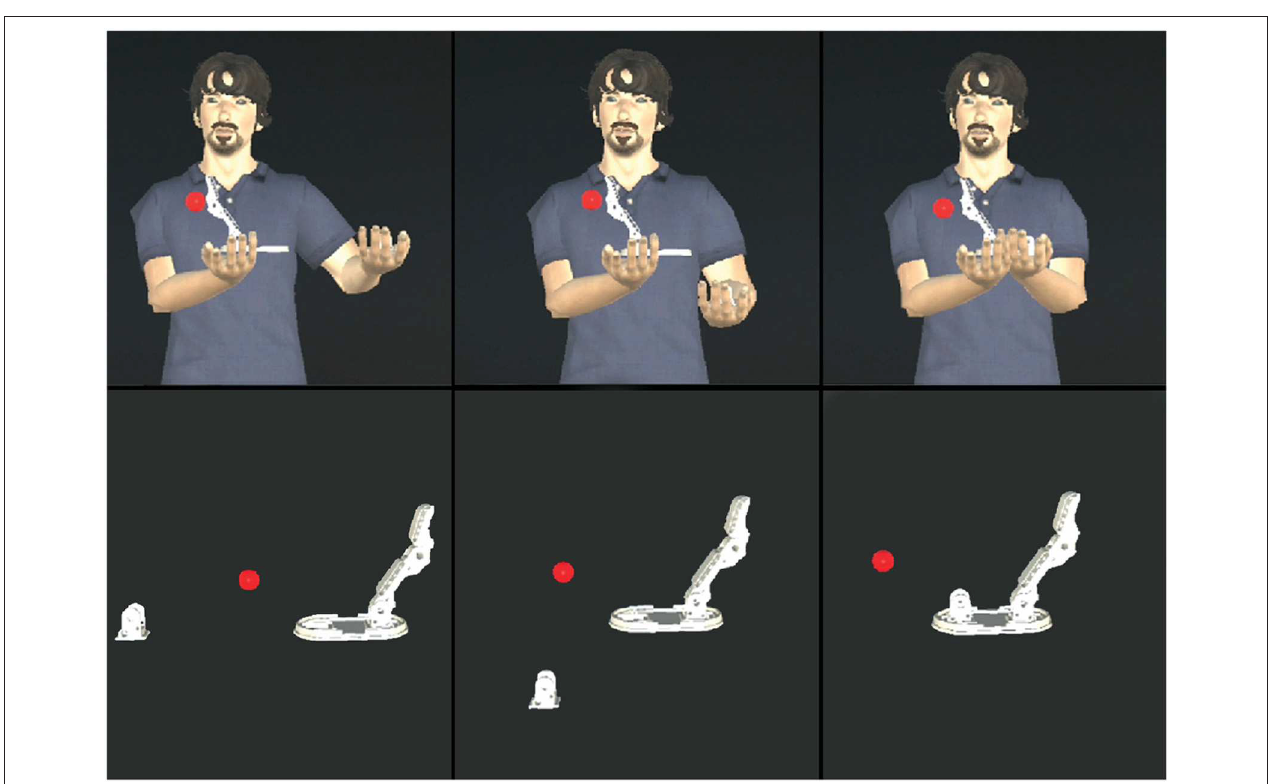
FIGURE 3 | First row: from left to right, one of the assembly animations played by the virtual avatar. Second row: the same animation played without the virtual avatar in the abstract AR interface.